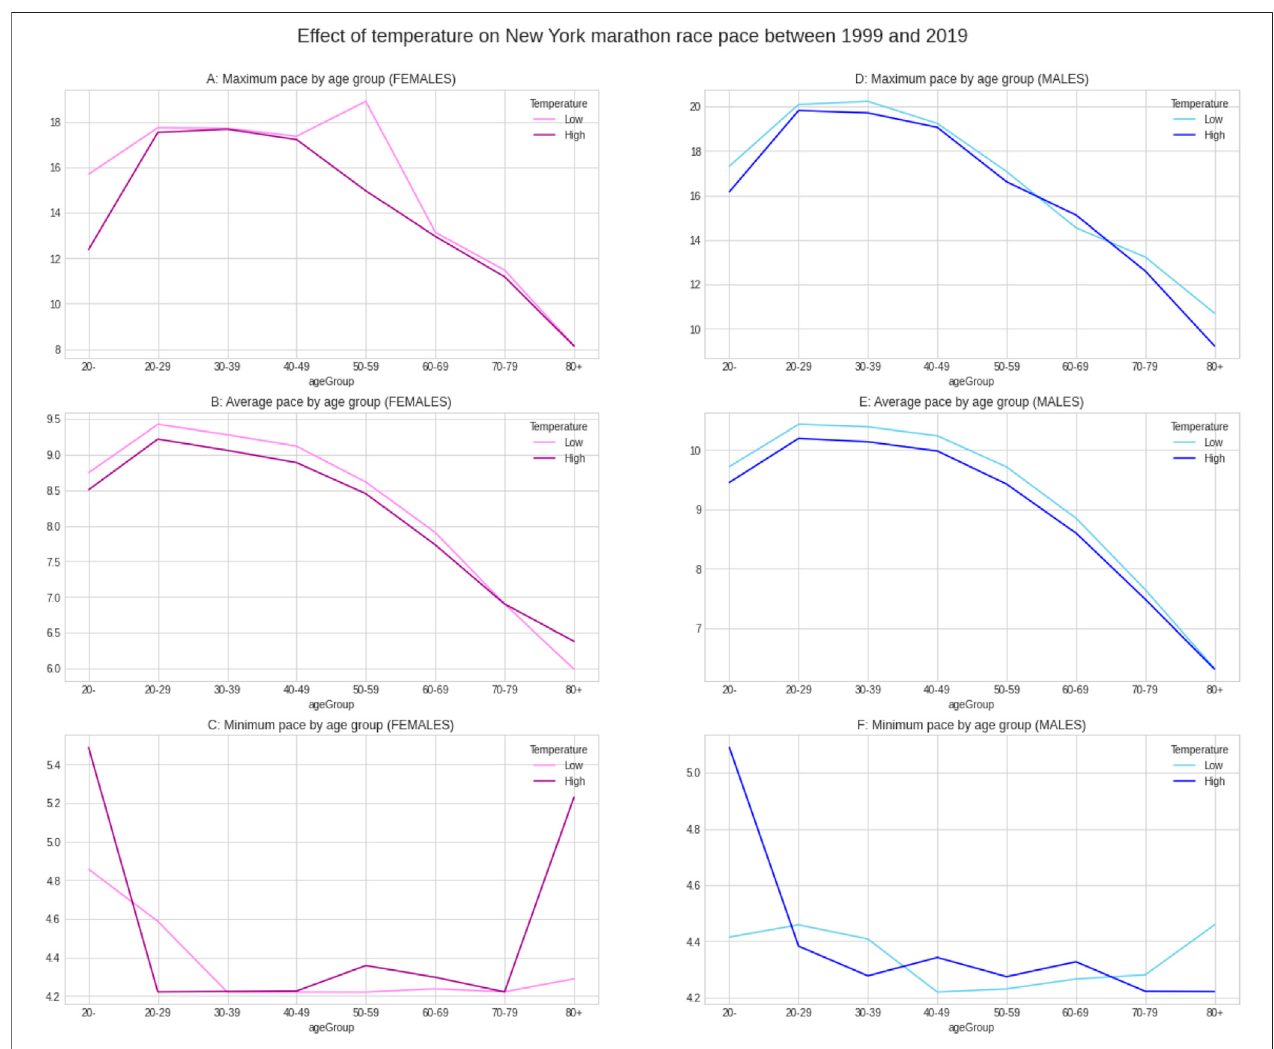
FIGURE 11 | Effect of temperature on running speed by age